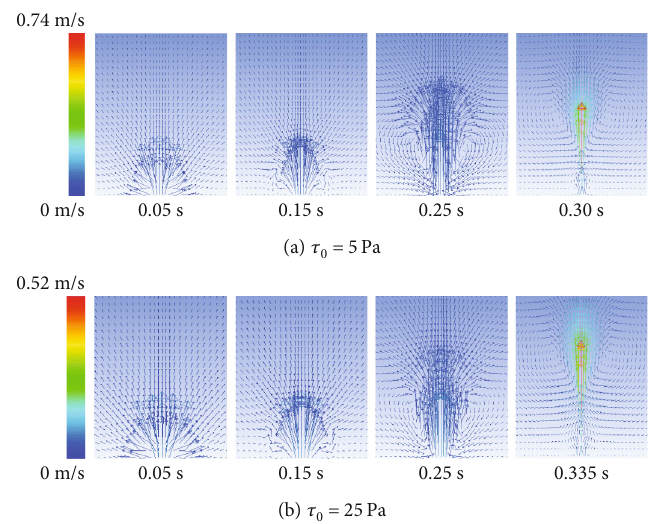
Figure 8: The velocity fi eld distribution inside and outside a bubble at di ff erent times and τ